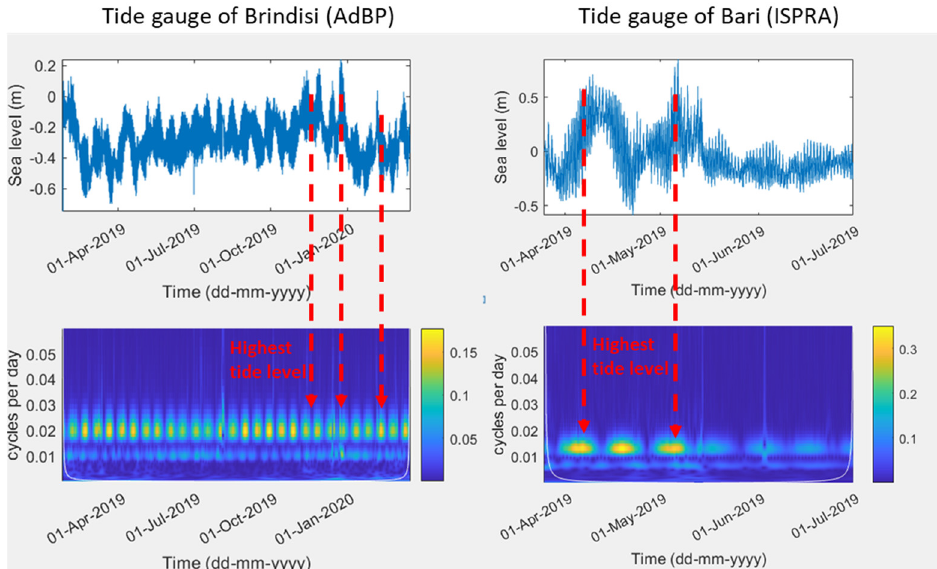
Figure 6. Spectral analysis performed on the tide gauge from Brindisi (property of AdBP) and tide gauge from Bari (property of ISPRA) showed the highest tide level reached in 2019–2020.